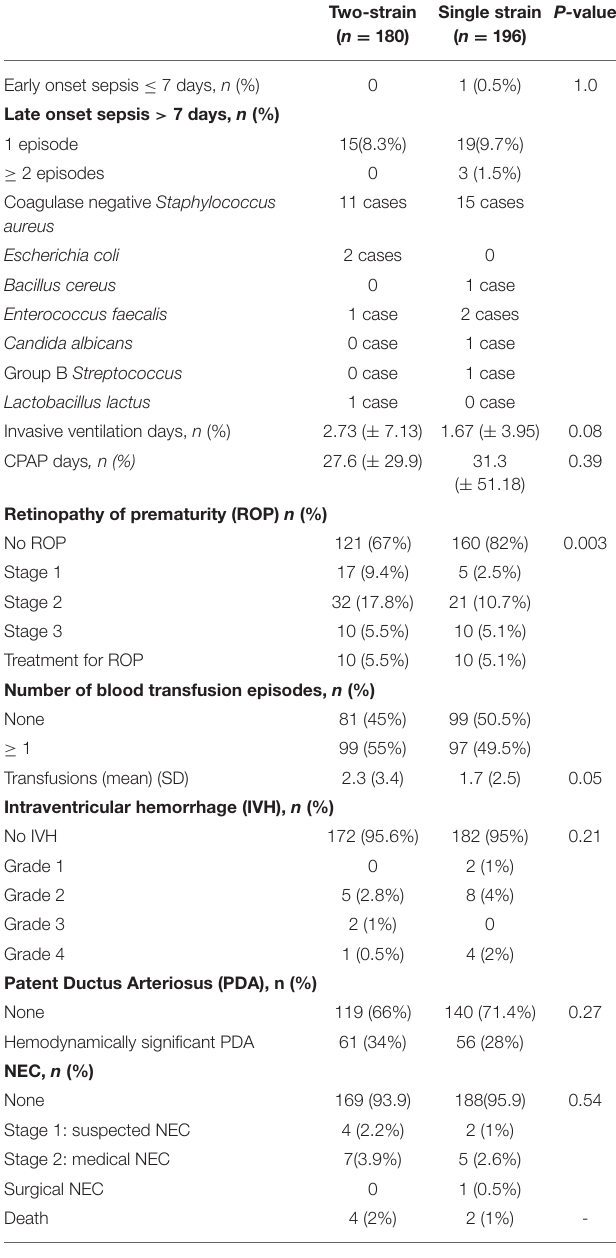
TABLE 3 | Comparison of the co-morbidities associated with prematurity in infants in the single versus two-strain probiotic group.